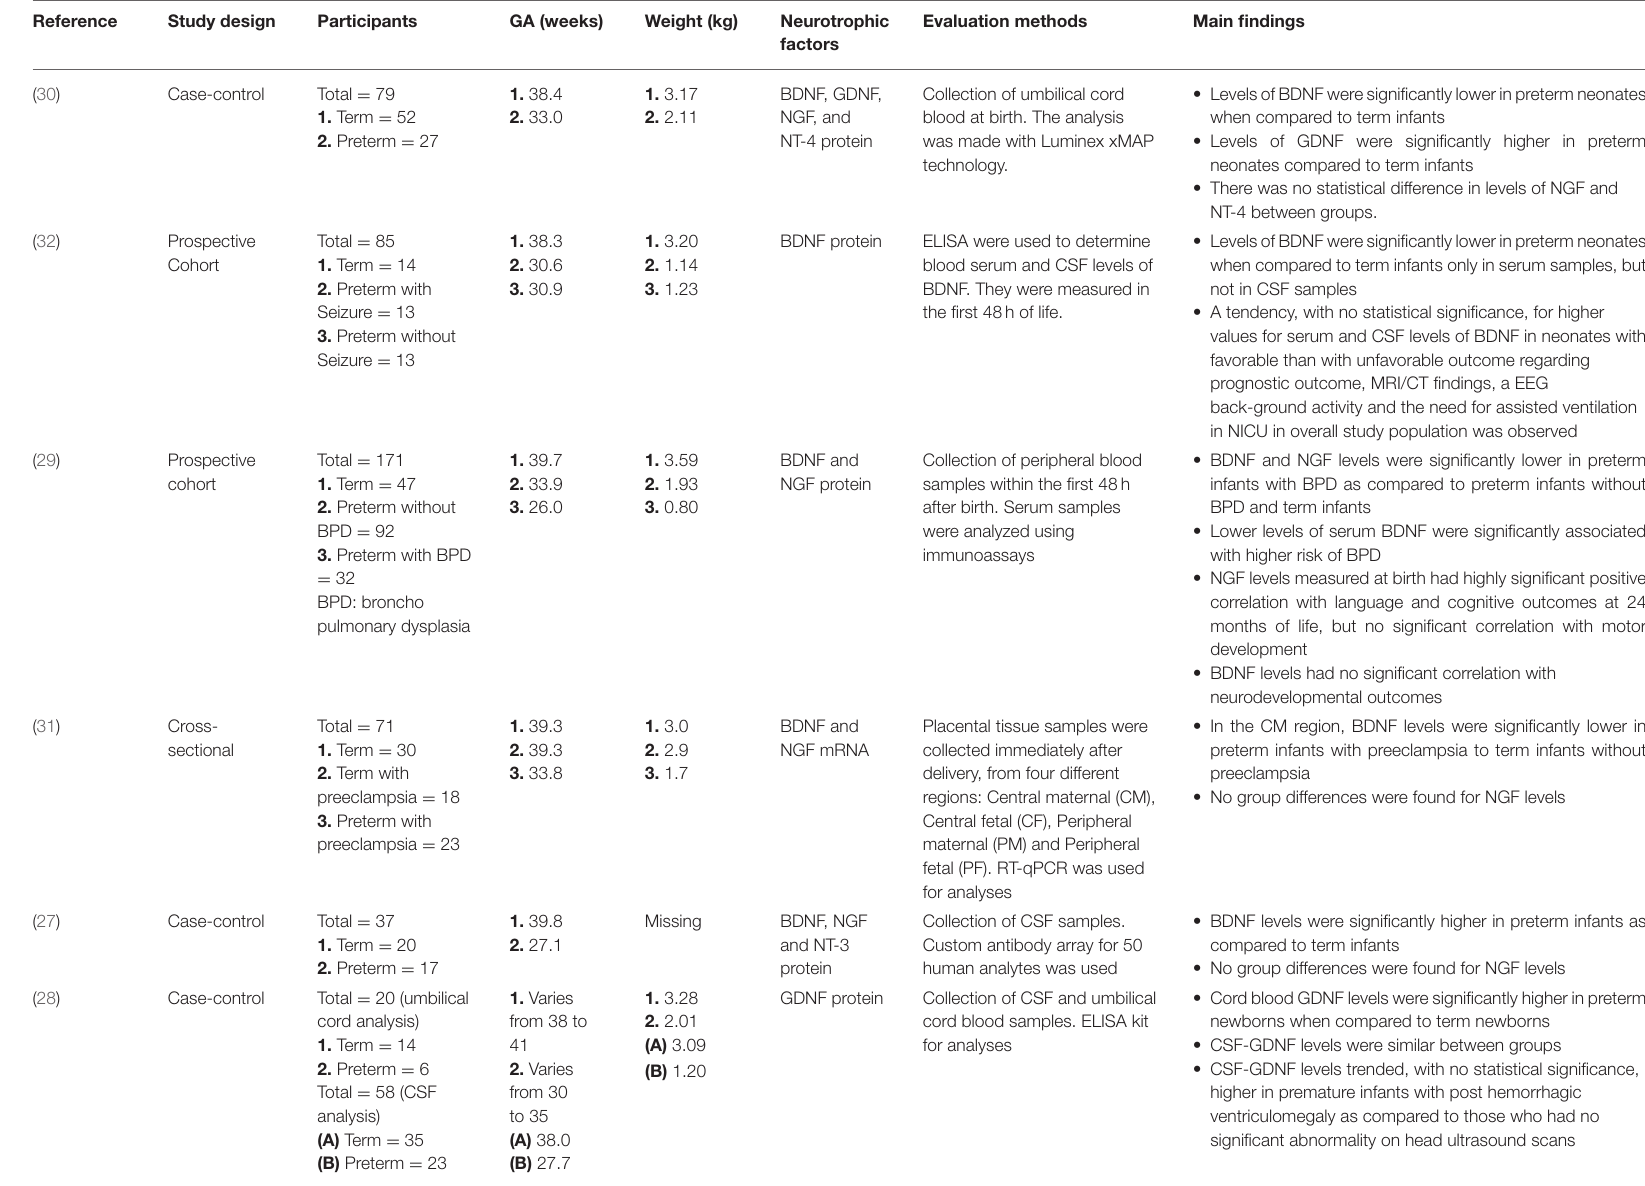
TABLE 1 | Characteristics of the included